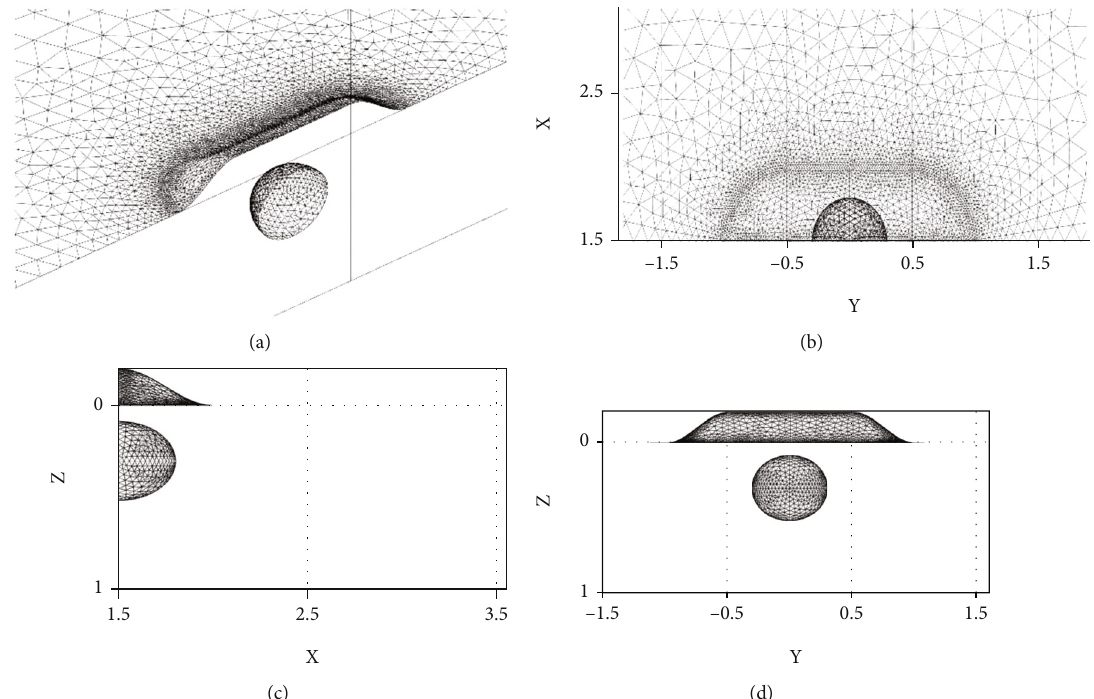
Figure 4: The mesh of the studied area of the simulated volume in the COMSOL Multiphysics program (FEM): (a) orthographic projection view, (b) plan view, and (c and d) cross-sectional views. For convenience, only half of the model on the x -axis is shown.